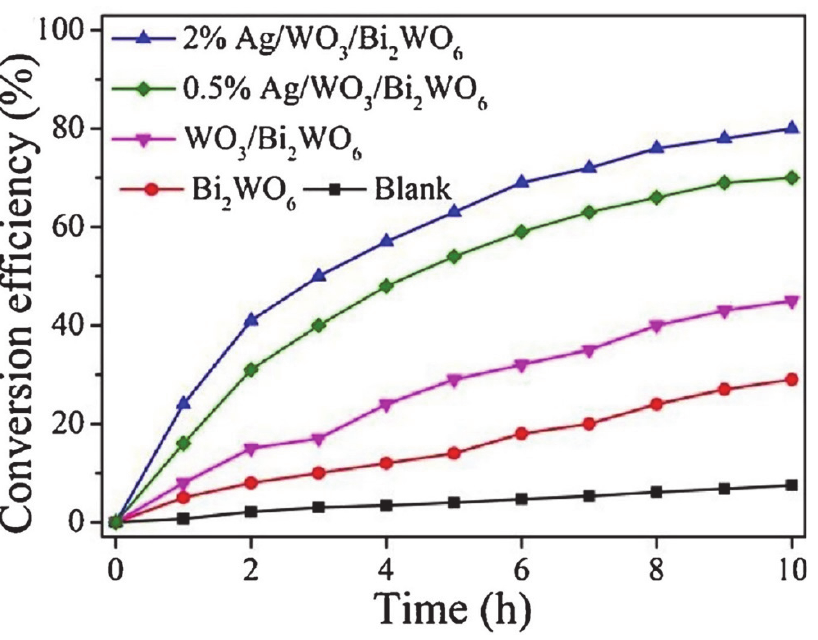
Figure 4. Comparison of the photocatalytic activity of the as-prepared samples for the photocatalytic degradation of chlorobenzene under simulated sunlight irradiation. (Reprinted with permission from Ref. [65]. Copyright 2019, copyright Elsevier).